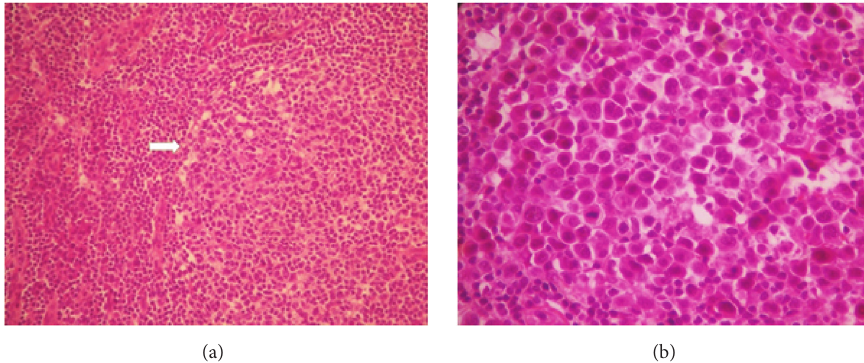
Figure 1: Histological examination of the lymph node. (a) Vaguely nodular lymphoid proliferation (arrow) in partially effaced architecture (HE × 100). (b) Plasmablastic cells with large eccentric nuclei, with atypical and often multilobulated contours. The cytoplasm is acidophilic and relatively abundant (HE × 400).